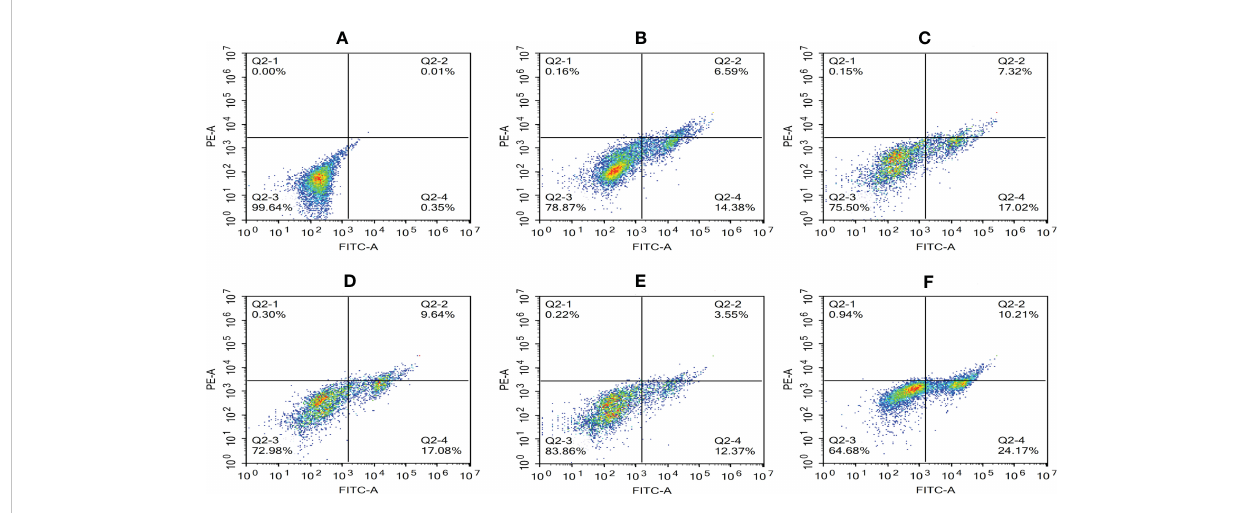
FIGURE 8 Proportion of apoptotic and necrotic cells at different time periods. (A) Uninfected cells: (B) 2 hpi, (C) 4 hpi, (D) 6 hpi, (E) 8 hpi, and (F) 12 hpi.